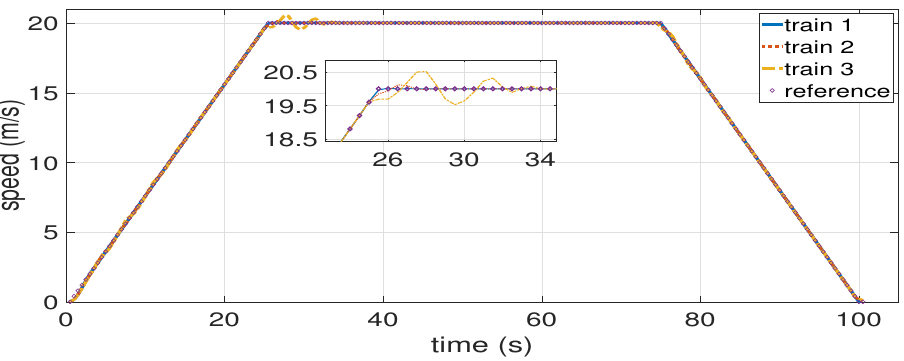
Figure 10. The speed profile of trains in VC driving on inter-station with AMPCVS